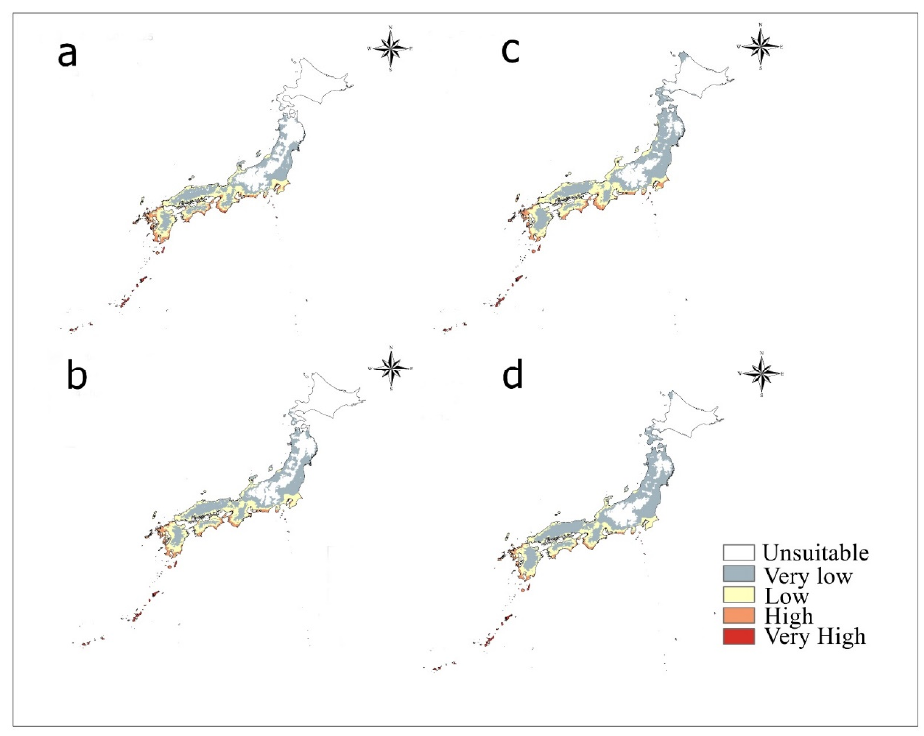
Figure 2. Risk map of future potential invasion of OWS to Japan under two representative concentration pathways: ( a ) RCP 2.6 in 2050, ( b ) RCP 8.5 in 2050, ( c ) RCP 2.6 in 2070, and ( d ) RCP 8.5 in 2070.